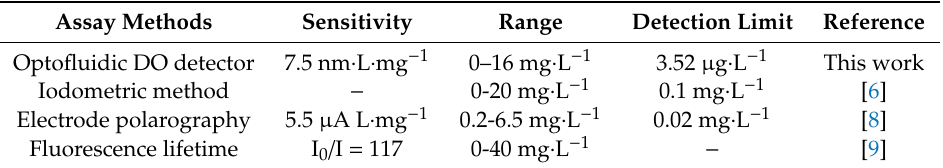
Table 1. Comparison of optofludic method with other DO detection